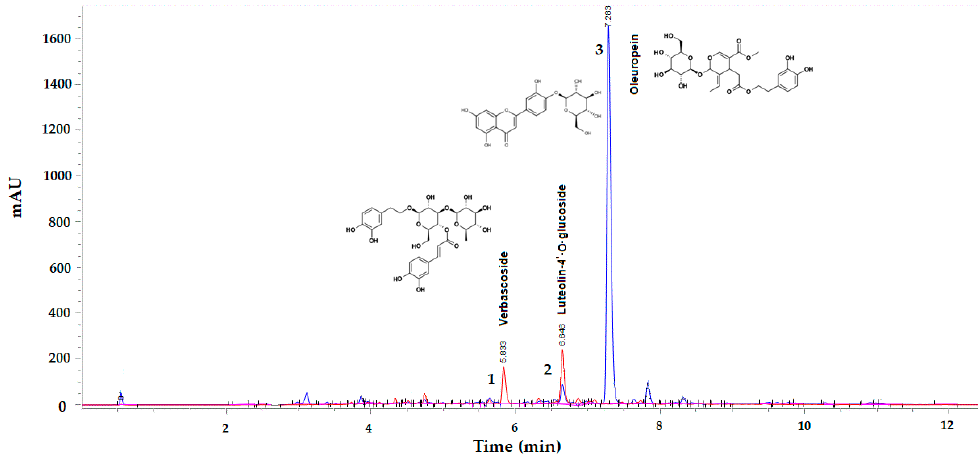
Figure 2. Representative ultrahigh-performance liquid chromatography with a diode-array detector (UHPLC-DAD) chromatogram of the olive-leaf phenolics extract. Peaks 1 and 2 were detected at 325 nm (lines in red), while peak 3 (line in blue) was detected at 280 nm.